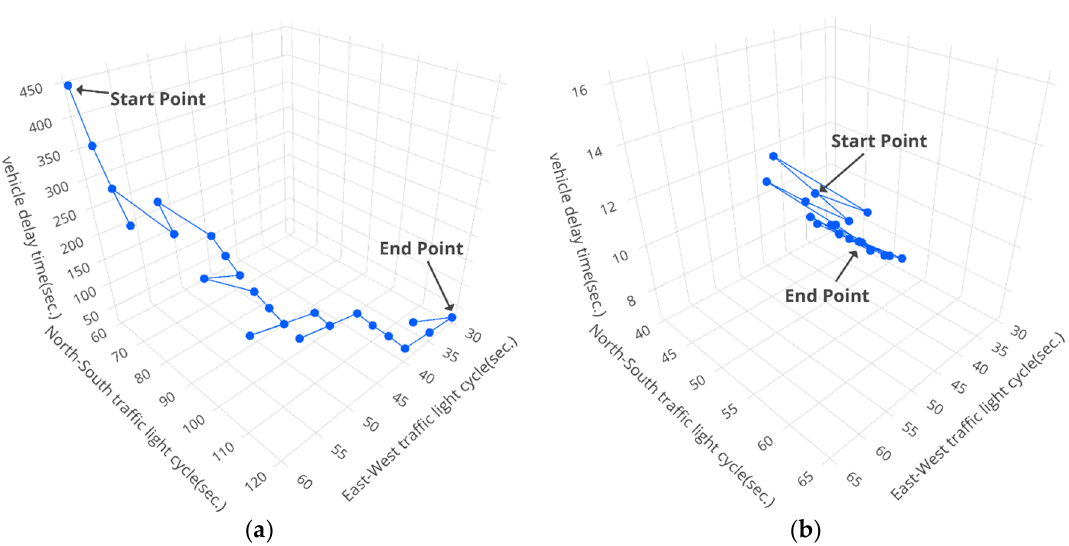
Figure 14. The results of vehicle delay by using our proposed modified Q-learning mechanism on Huanhe N. Rd and Nanjing W. Rd. ( a ) from 8:00 a.m. to 9:00 a.m. ( b ) from 5:00 p.m. to 6:00 p.m.